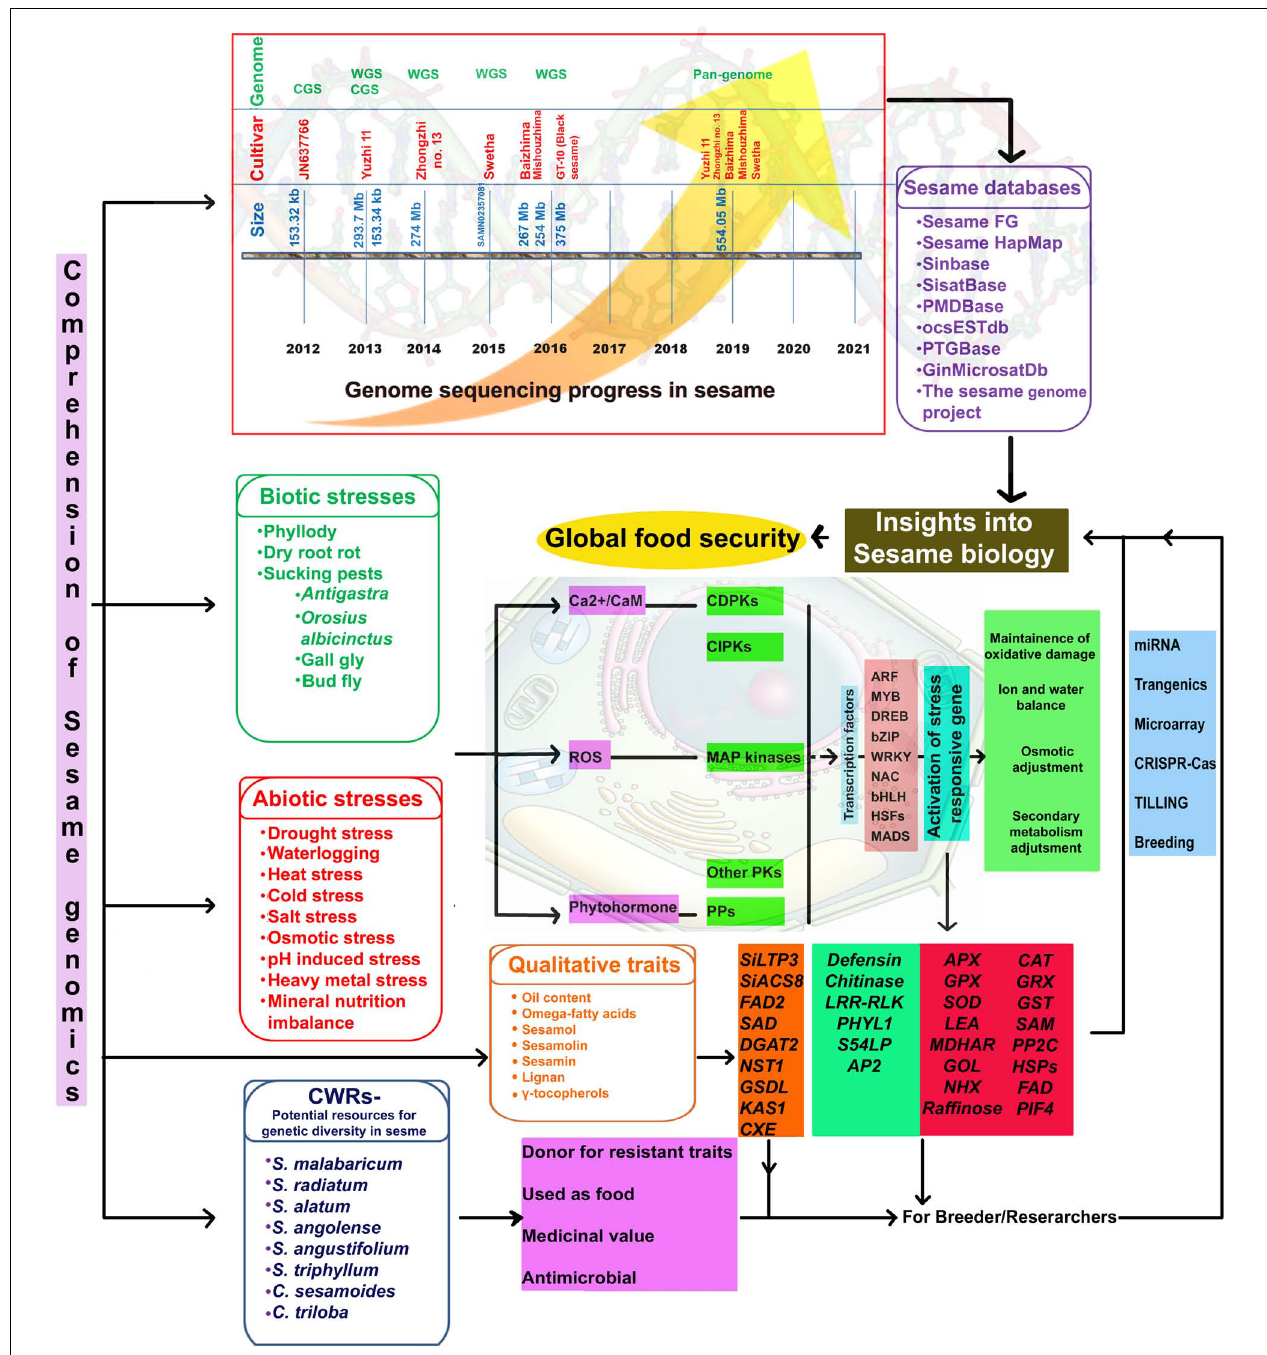
FIGURE 2 | Comprehension of sesame genomics for global food security. CGS, Chloroplast genome sequencing; WGS, Whole-genome sequencing; CWRs, Crop wild relatives; Ca 2 + , Calcium ion; CaM , Calmoldulin; ROS, Reactive oxygen species; CDPKs, Calcium-dependent protein kinases; CIPKs , CBL-interacting protein kinases PPs ; MAP kinases , Mitogen activated protein kinases; PKs , Protein kinases; PPs, Protein phosphatases; ARF , Auxin response factors; MYB , Myeloblastoma; DREB , Dehydration responsive elemental binding; bZIP -Basic leucine zipper domain; NAC , NAM [No apical meristem, ATAF, CUC (Cup-shaped cotyledon)]; bHLH , Basic helix loop helix; Hsfs , Heat stress specific transcription factors; MADS-M, minichromosome maintenance factor 1 from Saccharomyces cerevisiae ; A for Agamous (AG) from Arabidopsis thaliana (from now on, Arabidopsis ); D for deficient from Antirrhinum majus ; and S for serum response factor (SRF); APX , Ascorbate peroxidase; GPX , Glutathione peroxidase; SOD , Super oxide dismutase; LEA , Late embryogenesis abundant protein; MDHAR , Monodehydro ascorbate reductase; GOL , Galactinol synthase; CAT , Catalase; GRX , Glutathione reductase; GST, Glutathione-S-transferase; SAMe , S’adenosyl-l-methionine; PP2C , Protein phosphatase 2C; HSPs , Heat shock proteins; FAD , Fatty acid desaturase; PIF4 , Phytochrome-interacting transcription factor 4.